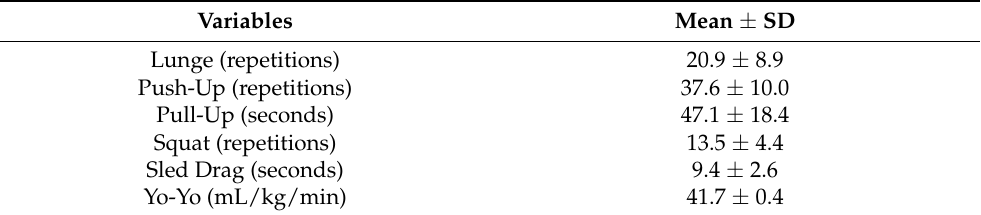
Table 1. Descriptive data for the SORT battery in part-time SWAT operators ( n = 14).